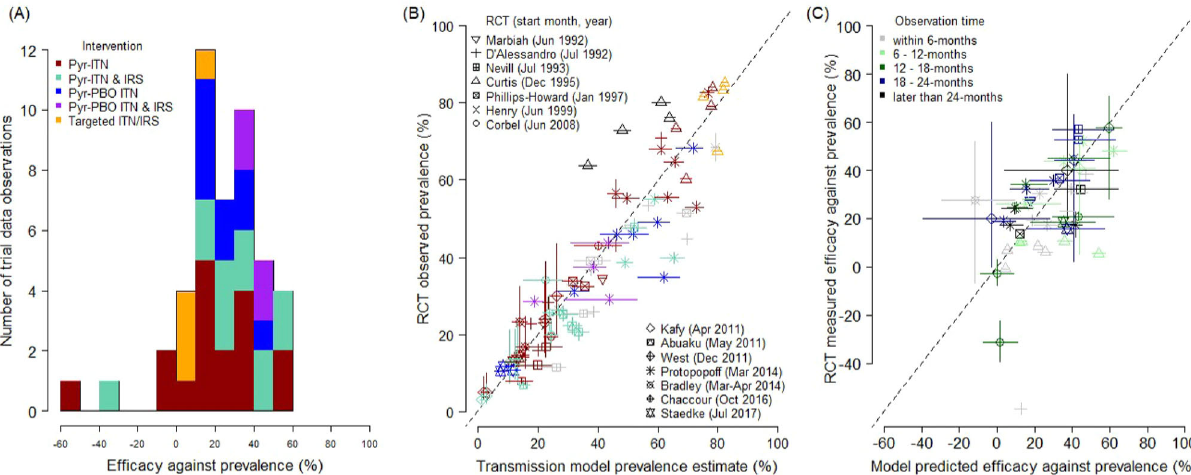
Fig. 2 Differences in the epidemiological impact of insecticide-treated nets (ITNs) and the residual spraying of insecticides indoors (IRS) as evaluated in cluster-randomised control trials (RCTs) and predicted by a entomological data. A Trial observed relative (to respective control arms as noted in Fig. 1, and Materials and Methods) ef fi cacy against prevalence estimated for 46 data observations (Supplementary Data S1.8). Bar colours indicate the different types of intervention examined. B Comparison between observed trial prevalence and prevalence predicted by the transmission dynamics model parameterised using entomological data (matching diagnostic method and cohort characteristics, Supplementary Data S1.7, best- fi tting parameters shown; Supplementary Table 3, column 4) for 13 RCTs, with symbols identifying principal investigators listed with the start date of the trial, that reported a total of 73 prevalence cross-sectional surveys. Colours indicate the type of intervention in the trial arm: pyrethroid-only nets (red), pyrethroid-PBO nets (blue), pyrethroid-only nets and IRS (green), pyrethroid-PBO nets and IRS (purple), or IRS only (orange). C Comparison of observed ef fi cacy estimates and those predicted by the model (Supplement Data S8). In C , colours denote the length of time in months since the deployment of interventions when the prevalence observation was made that was used to estimate ef fi cacy. Individual model predictions for each study are given in Supplementary Figs. S3 – S15 with equivalent fi gures for alternative methods of combing data shown in Supplementary Fig. S18. Vertical and horizontal solid lines around point estimates (mean) for either observed or predicted data indicate 95% uncertainty from intervention performance, while dashed black line in B and C show the equivalence line. Uncertainty estimates for the observed data found in Supplementary Data S1.3 and for the different models in Supplementary Data S1.7 and 1.8 for B and C ,